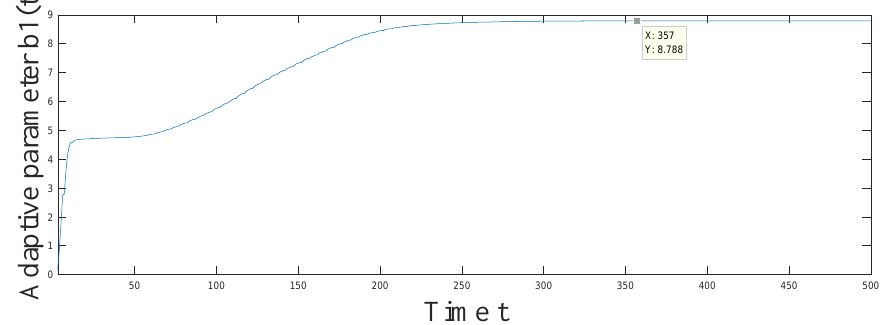
Figure 5. Trajectory of control parameter b 1 ( t ) of the adaptive controller (36) in Example